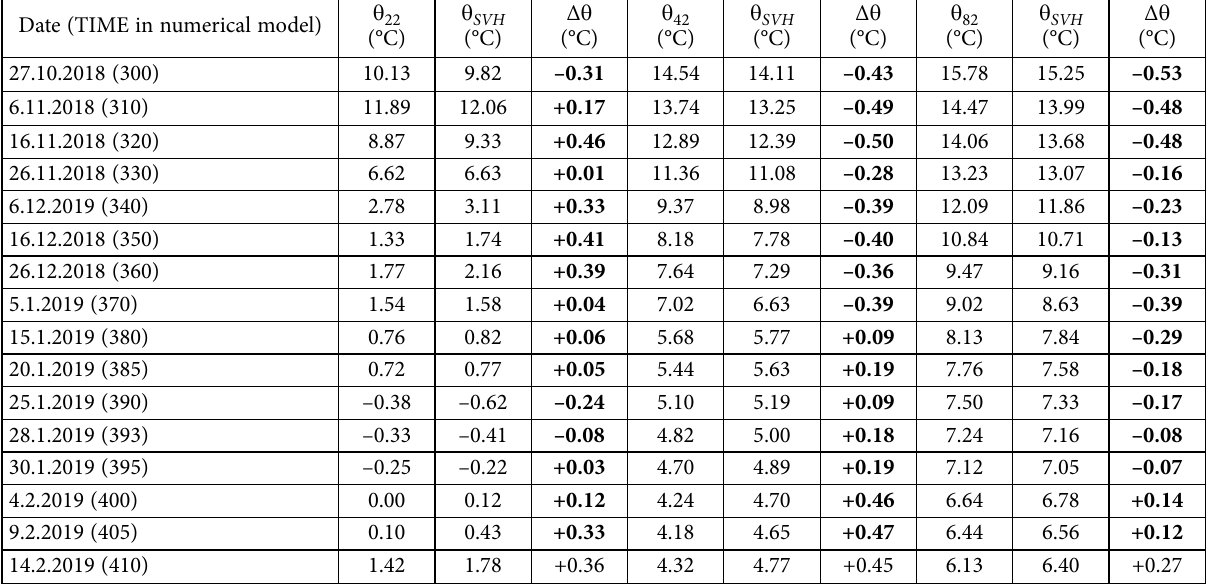
Table 3. Comparison of temperatures of individual track bed layers determined by experimental and numerical methods Date (TIME in numerical model)